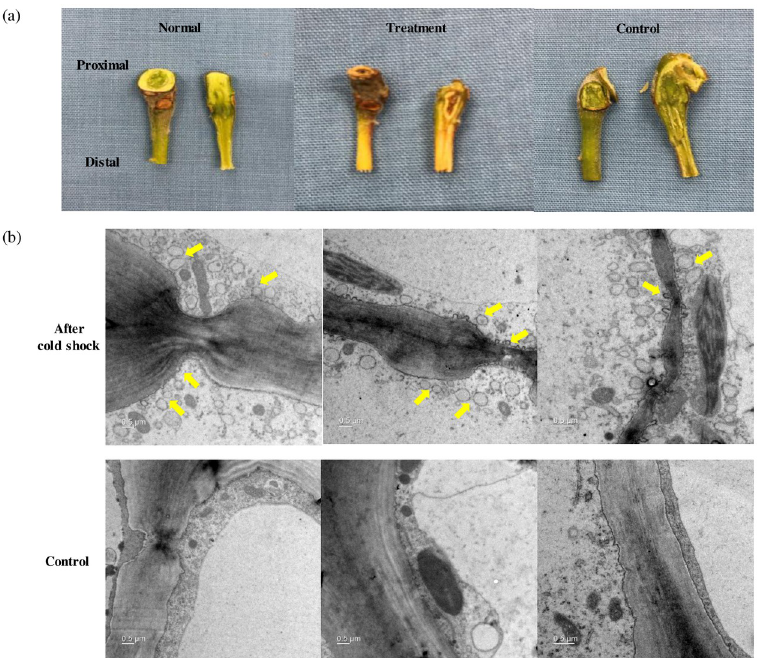
Fig 2. Morphological changes of an excised Hongro/M9 apple tree subunit after ex vivo cold shock followed by 168 hr of incubation at 25 ˚C. (a) Comparison of pedicel tissues containing the abscission zone (AZ) (left: normal, before the incubation; middle: treatment, cold shock followed by the incubation; right: control, after the incubation). (b) Transmission electron microscopy images of the AZ cortical cells at proximal tissues in the pedicel (top: cold treatment, 168 hr of incubation following initial 2 hr of cold shock; bottom: control, 168 hr after incubation without cold shock). Samples were observed with a LIBRA 120 transmission electron microscope at an acceleration voltage of 120 kV, magnification of 4 k (left, middle) and 6.3 k (right). Arrows indicate the development of cytoplasmic vesicles.